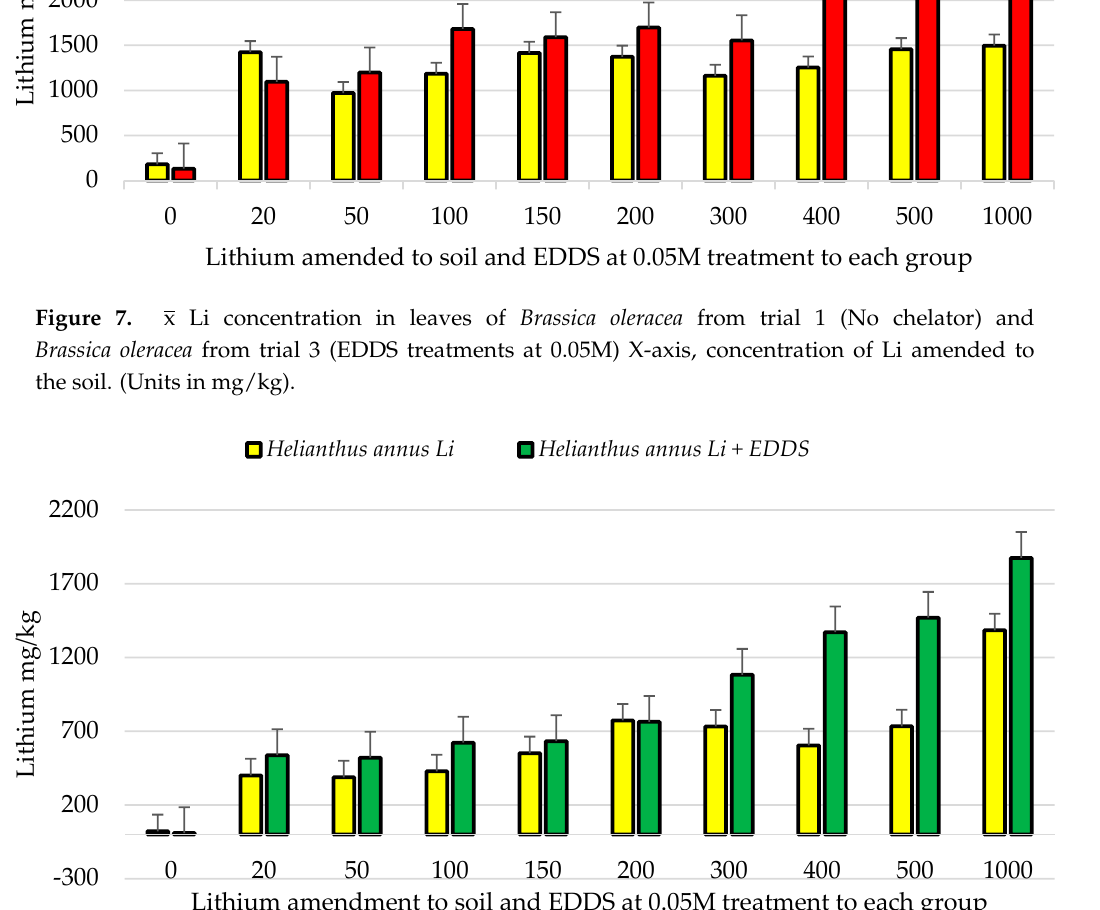
Figure 8. x ̅ Li concentration in leaves of Helianthus annuus from trial 1 (no chelator) and Helianthus annuus from trial 3 (EDDS treatments at 0.05M) X-axis, concentration of Li amended to the soil (Units in mg/kg).